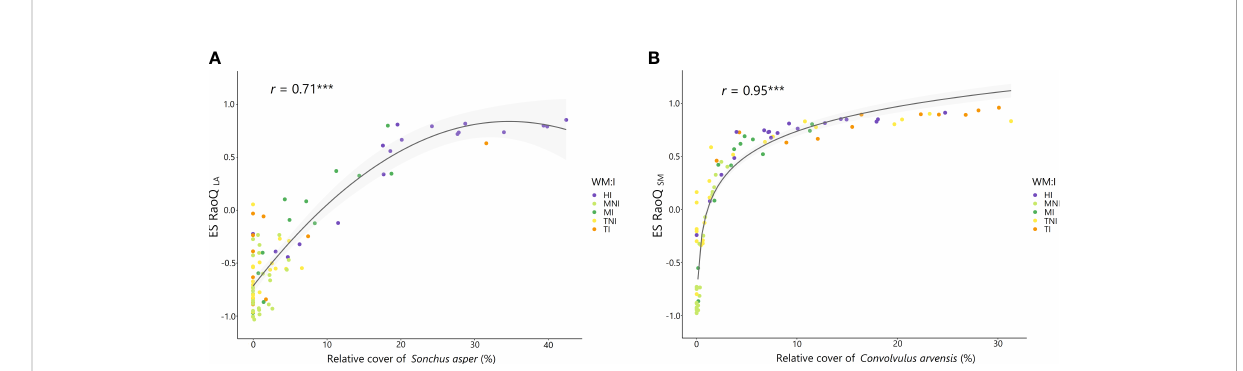
FIGURE 4 Relationship between the relative cover of Sonchus asper and effect size of RaoQ for leaf area (ES RaoQ LA ) (A) and between the relative cover of Convolvulus arvensis and effect size of RaoQ for seed mass (ES RaoQ SM ) (B) . Dots, corresponding to plots, have been fi lled in by the interaction of weed management and irrigation (WM:I): HI, herbicide – irrigation; MNI, mowing – non-irrigation; MI, mowing – irrigation; TNI, tillage – non-irrigation; TI, tillage – irrigation. For each correlation, Spearman correlation coef fi cient ( r ) and its level of signi fi cance (*** P < 0.000) are shown. Con fi dence intervals (95%) are shaded in light